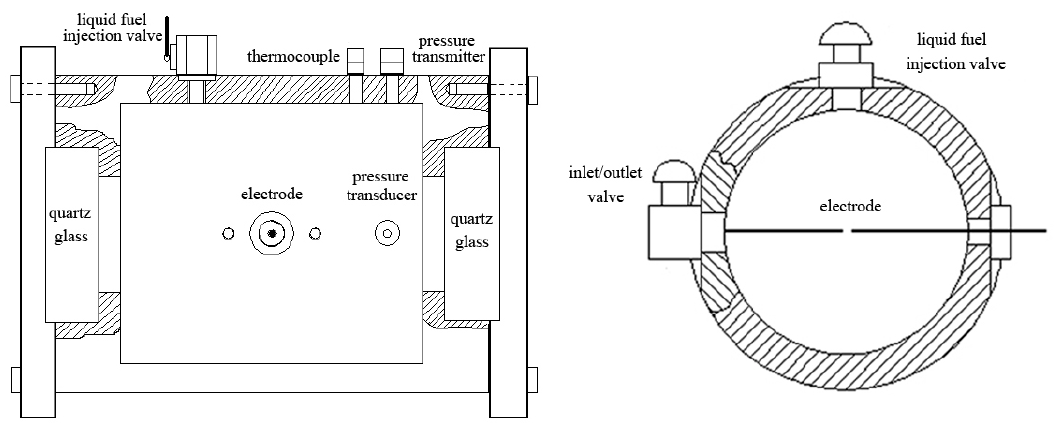
Figure 2. Schematic diagram of the constant volume combustion chamber.